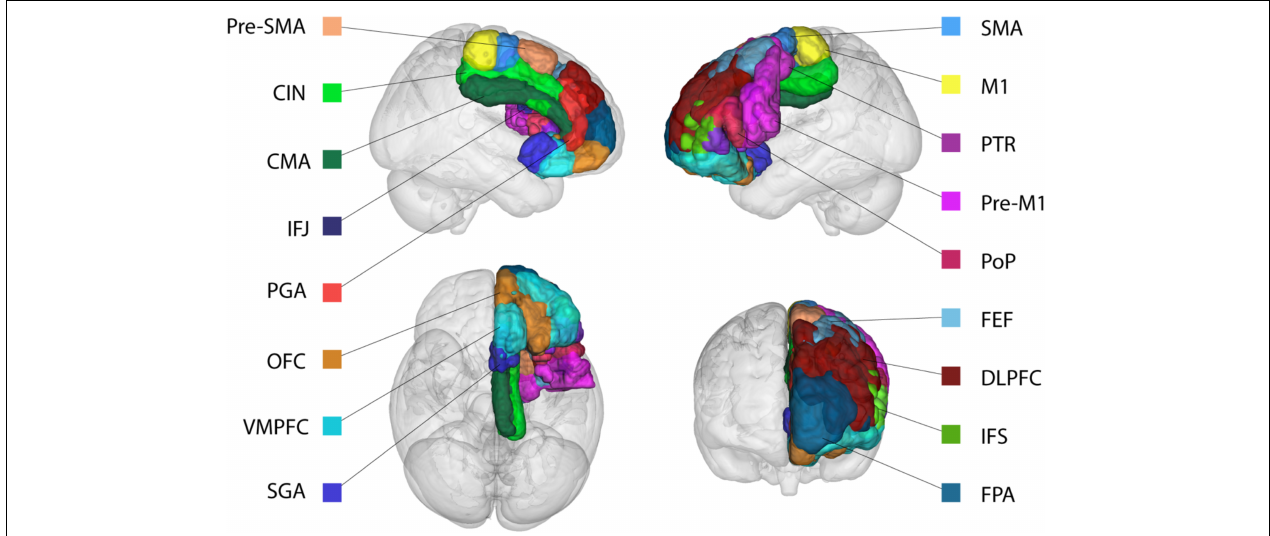
FIGURE 1 | Representation of the cortical region of interests (ROIs). Based on the literature search, all areas have a non-human primate homolog and structurally connect to both the STN and STR in non-human primates. For visualization purposes only the ROIs in the left hemispheres are displayed. See Table 1 for abbreviations. TABLE 2 | Summary statistics of the tract lengths between the cortical areas and the STN and STR averaged over hemispheres. STN STR Mean SD Mean SD BF